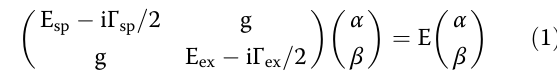
where E and E are the energy of the plasmon in sp ex ; g is nanocavity and the A exciton in monolayer MoS 2 the coupling strength of the system; Γ and Γ sp ex represent the dissipation rate of plasmons and excitons, respectively; E represents the eigenvalues corresponding to the energies of the new plexcitons; α and β are the eigenvector components. Solving the Eq. (1) and assuming the widths of exciton and plasmon are small compared to their energies and neglecting the high order parts in the widths of exciton and plasmon, we can get the solution Eq. (2): ffiffiffiffiffiffiffiffiffiffiffiffiffiffiffiffiffiffi r 1 ð 2 Þ δ 2 g 2 þ 4 – E represents the detuning energy between here, δ = E sp ex the A exciton of monolayer MoS and plasmon in 2 data and the numbers of PE layers is shown in Fig. S2.